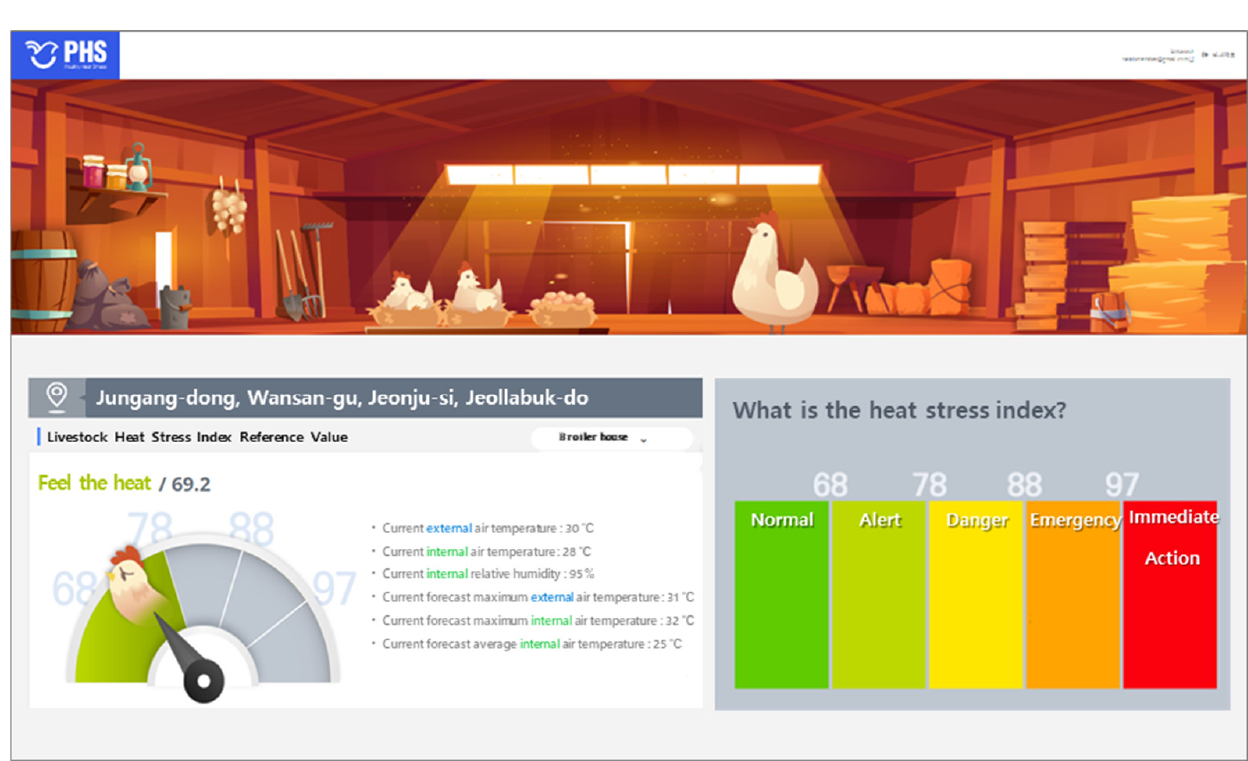
Figure 11. A sample image showing the web-based forecasting system for broiler heat stress.